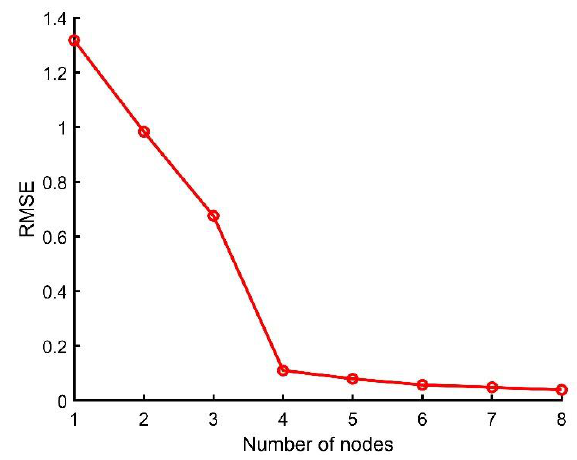
Figure 4. The structure identification diagram of IALM-ESC algorithm.